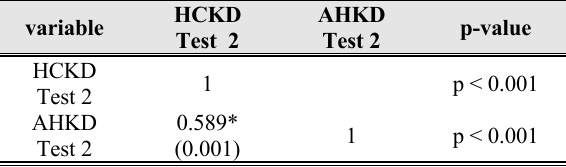
Correlation between HCKD and AHKD (Test 2)